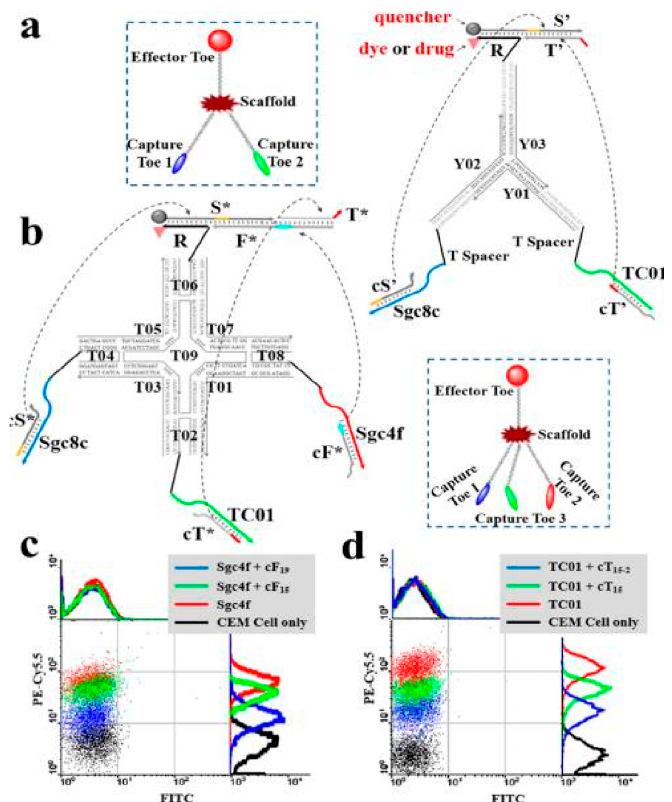
Figure 8. Schematic illustration of modular logic gates assembly for targeted photodynamic therapy.